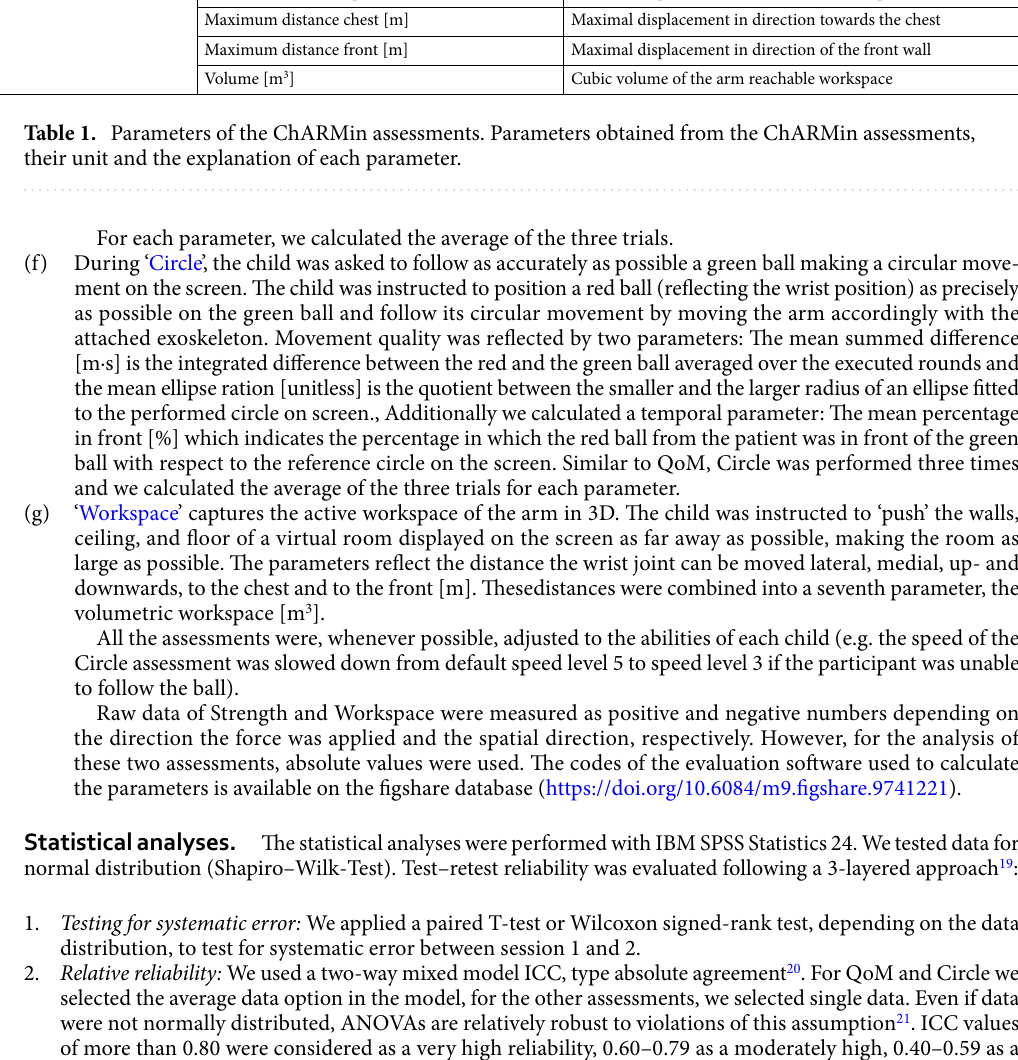
Table 1. Parameters of the ChARMin assessments. Parameters obtained from the ChARMin assessments, their unit and the explanation of each